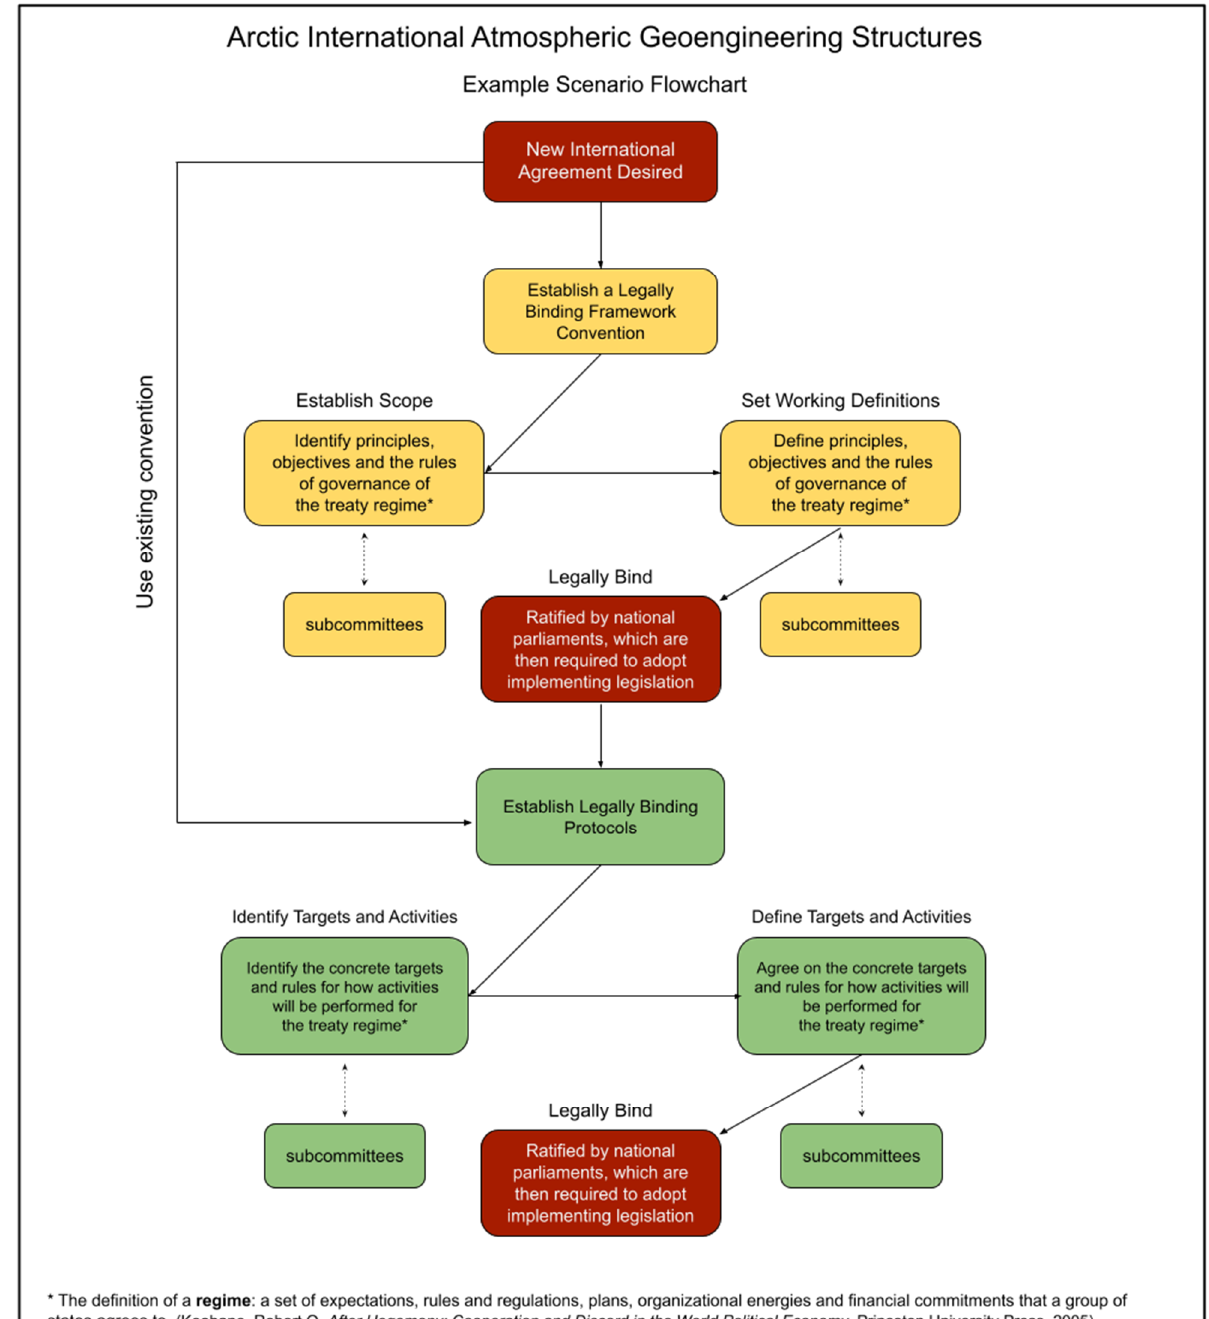
Figure 2. Sample possible flowchart for international agreements.